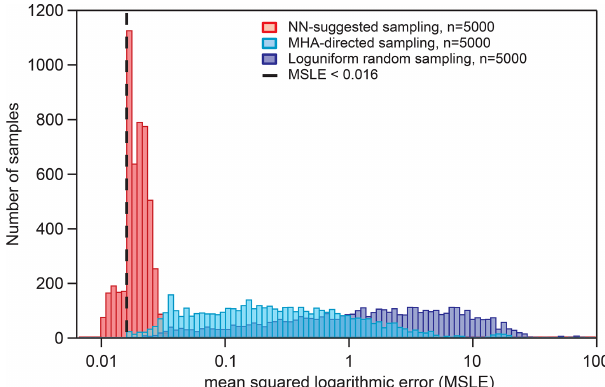
Figure 6. Distribution of KM-SUB output MSLEs for three differ- ent sampling methods in comparison with six sets of experimen- tal data, as described in Sect. 2.6. The dashed vertical line repre- sents the threshold used for the acquisition of NN-suggested fits (MSLE < 0 . 016). The maximum step size for the MHA-directed sampling is